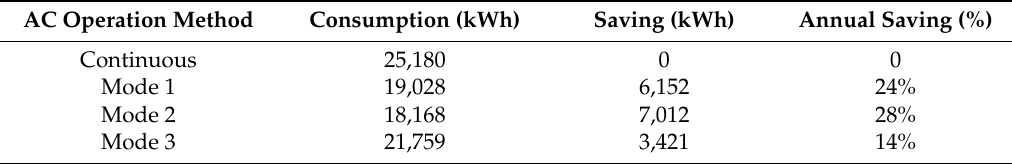
Table 9. Annual energy consumption under the continuous and different modes of AC operation for the Flat.